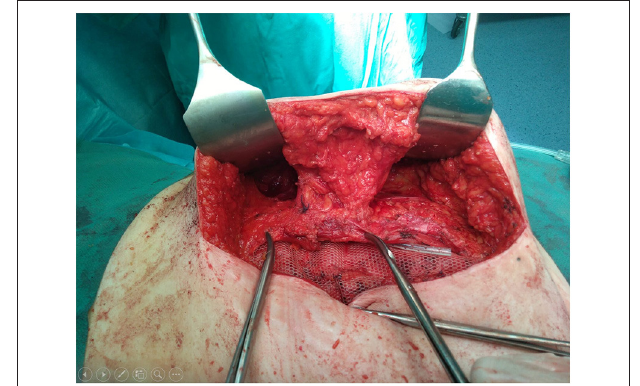
FIGURE 4 | View of the operative field after anterior component separation (ACS) with periumbilical rectus abdominis perforator vessels preservation according to